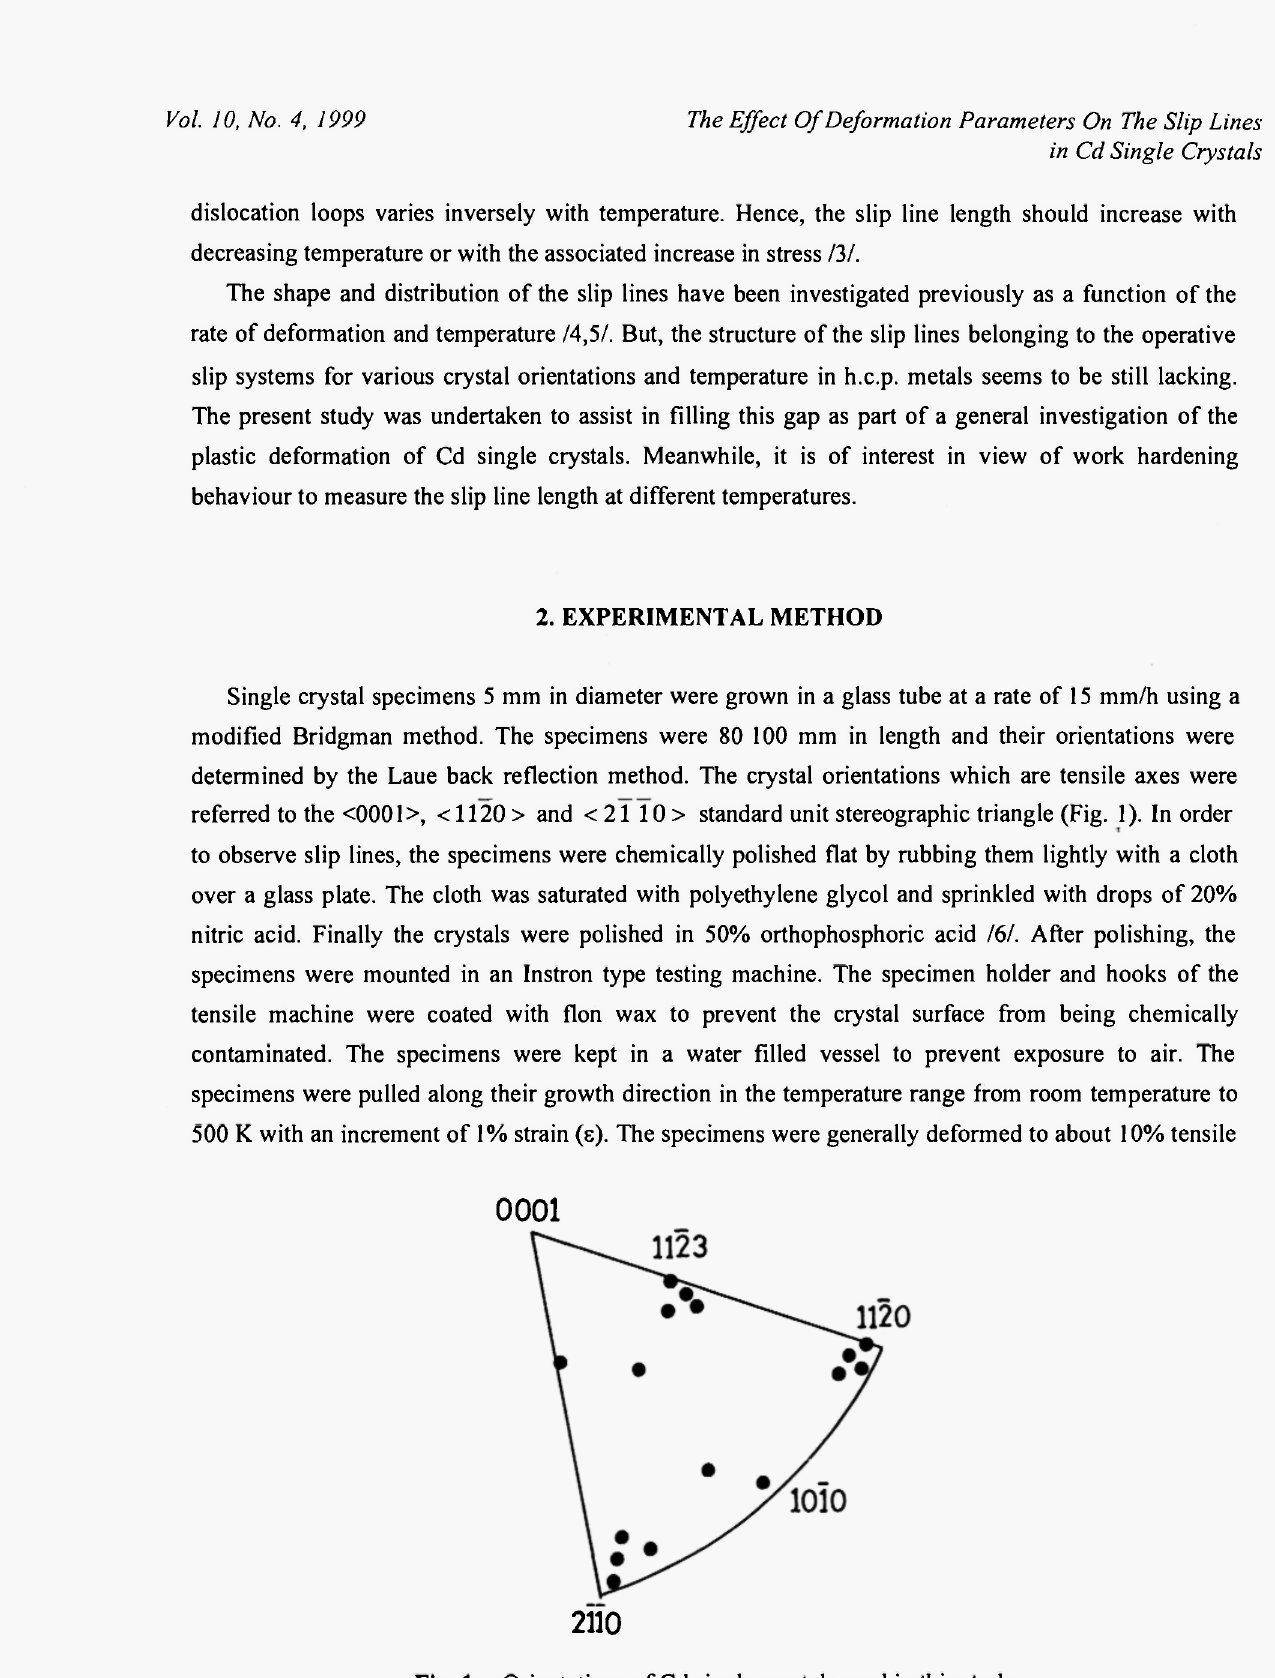
Fig. 1: Orientations of Cd single crystals used in this